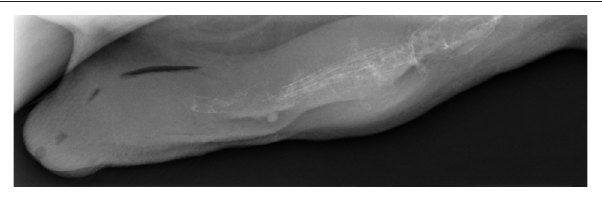
FIGURE 1: Sagittal diagnostic ultrasound images of the caudal os penis region, (a) the obstructive haemangiosarcoma mass between the cursors is located cranially to the anechoic dilated urethra and (b) slightly different imaging plane showing the irregular hyperechoic os penis remnants with some acoustic shadowing within the haemangiosarcoma.